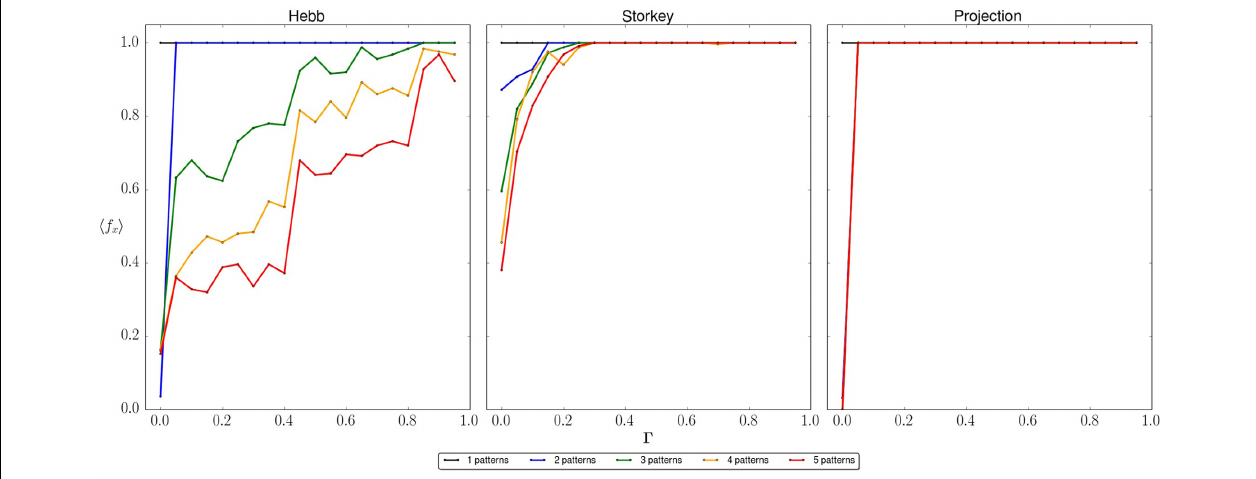
memories. Each panel plots the average recall success of a learning rule (Hebb, Storkey, projection) using an input state that is Hamming distance 0 from a stored